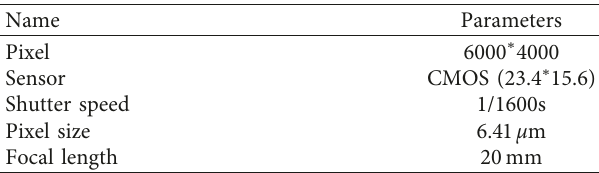
Figure 3: Flood image data acquired by UAV in the study area. Table 1: Camera parameters of Sony